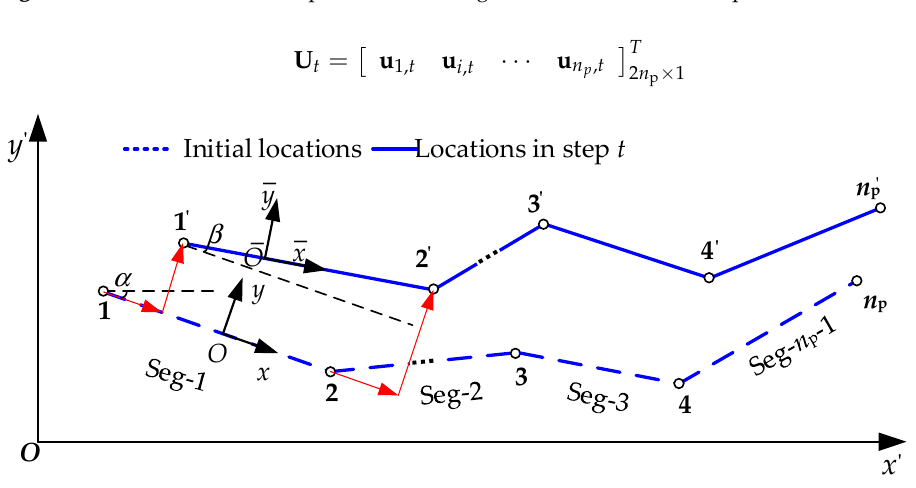
Figure 4. Stress and modulus update flow during the iterative calculation process.